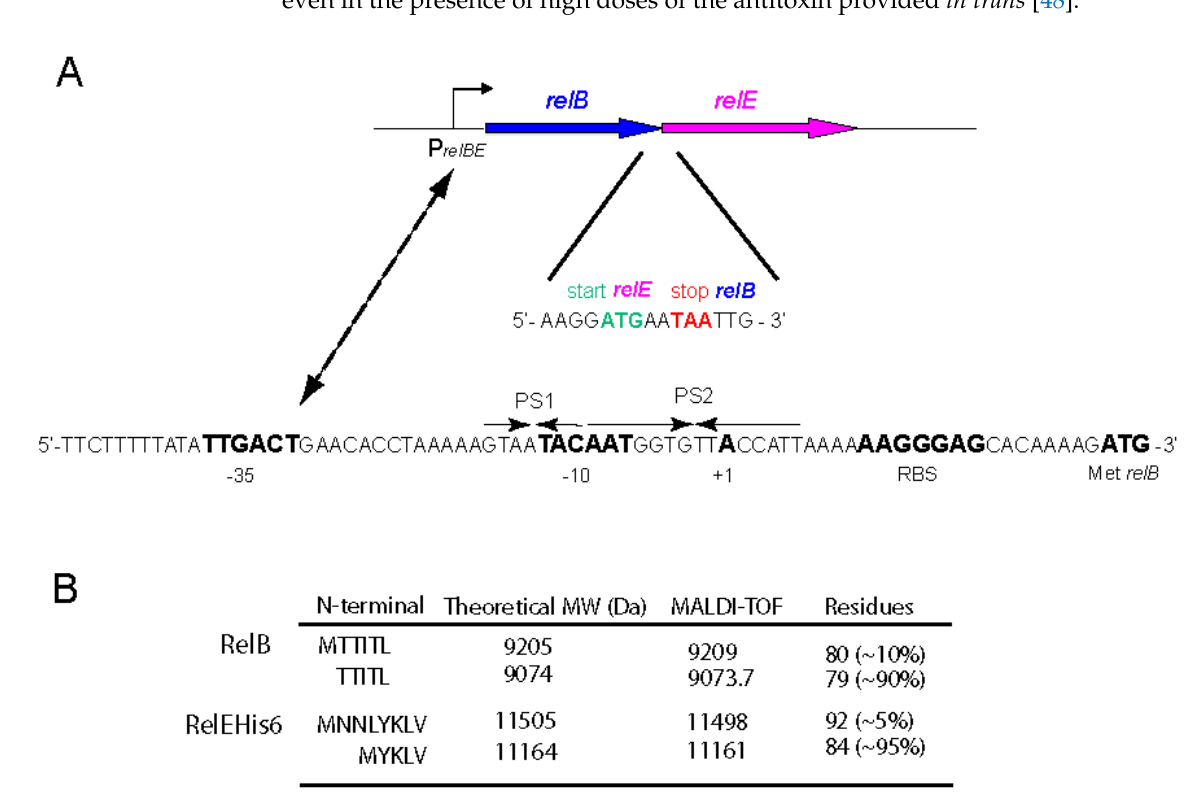
Figure 1. The relBE operon and the control region and features of the proteins it encodes. ( A ). Transcription of both genes is directed by a single promoter (P relBE ) and the intervening sequence of both genes shows that the initiation codon of relE (green) is placed just before the stop codon of relB (red). The promoter P relBE , with the − 35 and − 10 boxes (boldface), the transcription start point (+1), the ribosome binding site (RBS) and the initiation codon of relB are indicated. The two palindromic sequences (PS) are indicated by arrows. ( B ). MALDI assays showing the N-terminal amino acid composition of the purified RelB and RelEHis 6 proteins. In the case of antitoxin RelB, ~90% of the proteins showed processing of the initial Met residue, whereas only 5% of the purified toxin RelE exhibited the M-N-N residues extension at the N-terminal end of the protein.